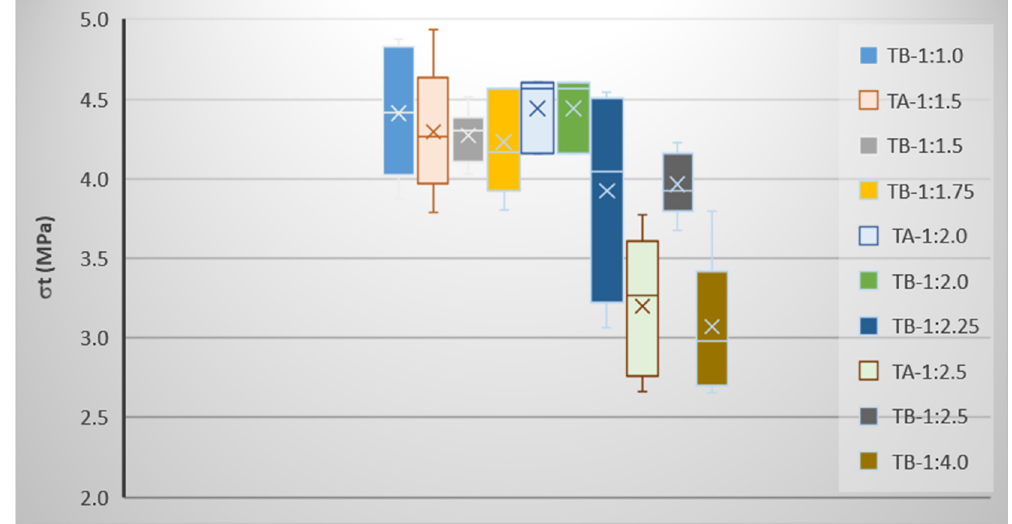
Figure 2. Statistical tensile strength for Type A and Type B mixes.